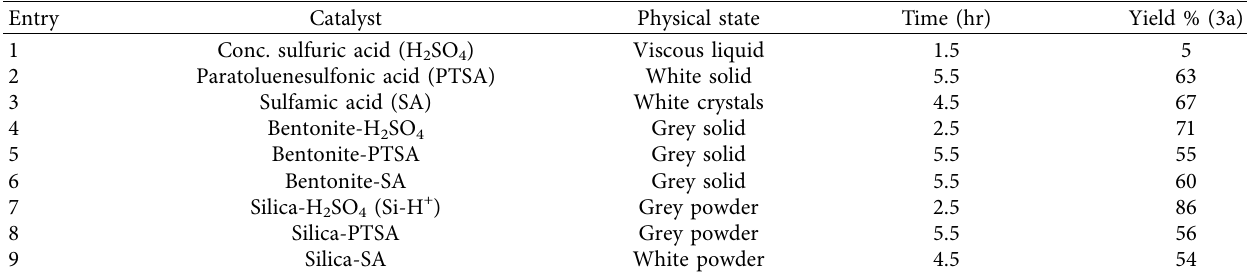
Table 1: Optimization of the catalyst for the preparation of phenolic ester 3a using the direct condensation reaction. Entry